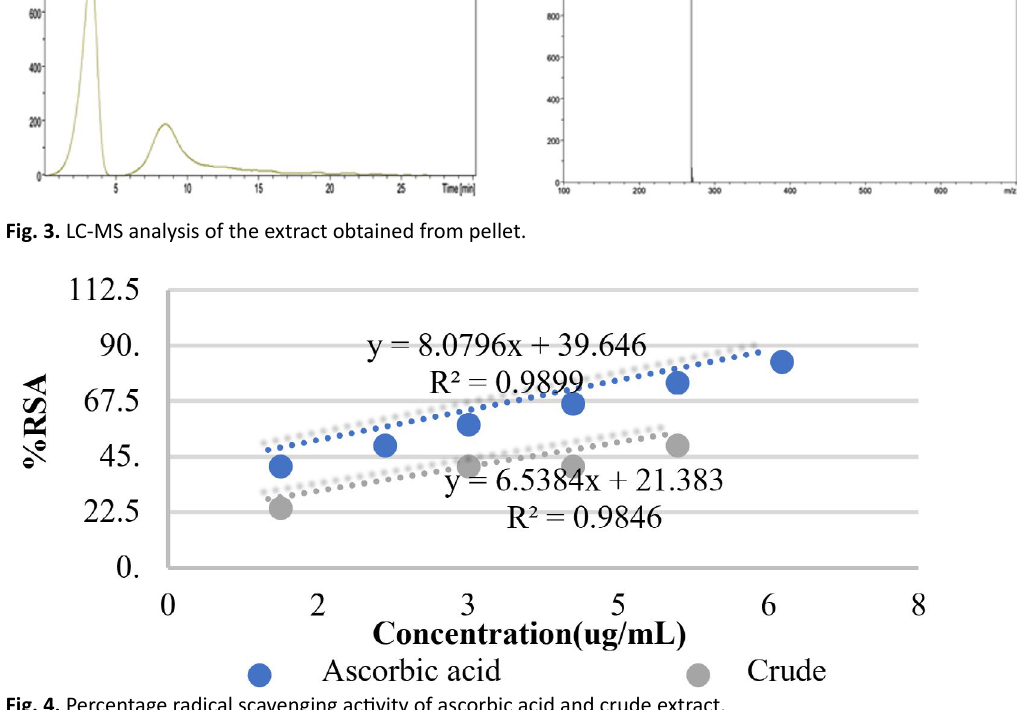
Fig. 4. Percentage radical scavenging activity of ascorbic acid and crude